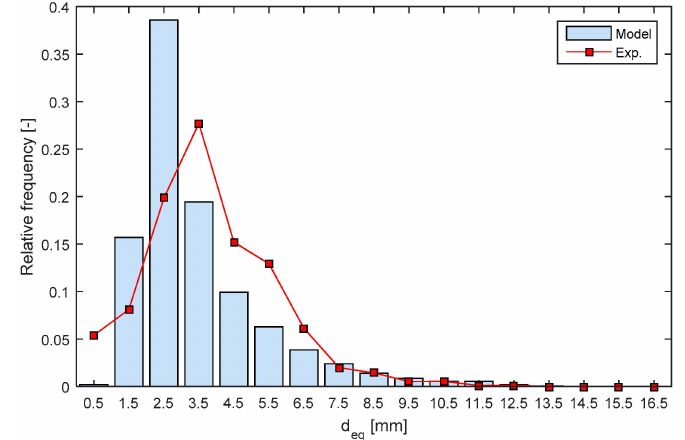
Figure 2. Comparison between the population balance model (PBM) results and experimental data: U G = 0.0037 m/s.